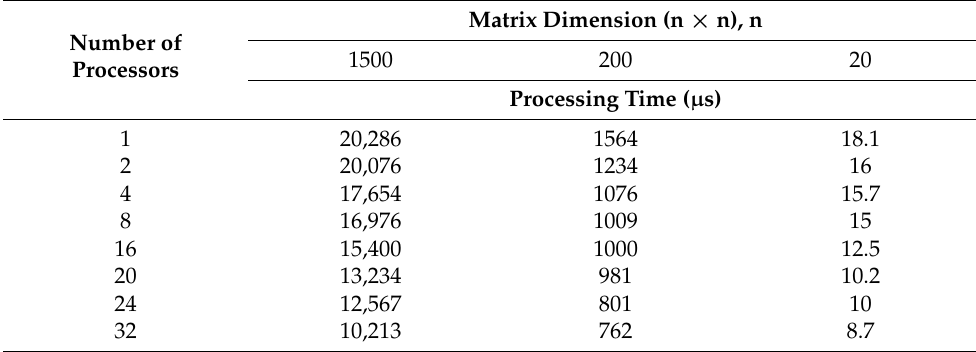
Table 3. Dependence of processing time on the number of computational processes and the size of the